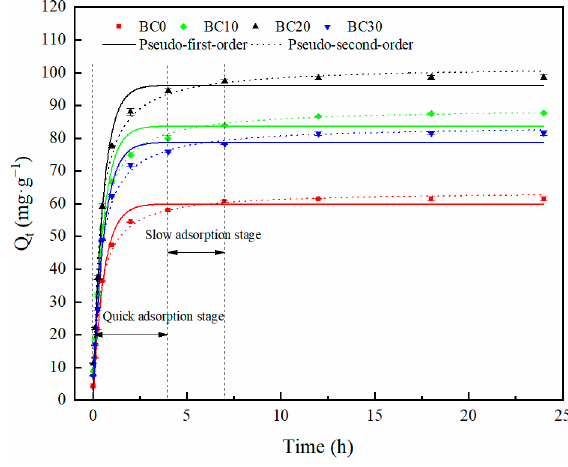
Figure 7. Adsorption kinetics of Cd 2+ onto biochars: pseudo-first-order model and pseudo-second- order model.